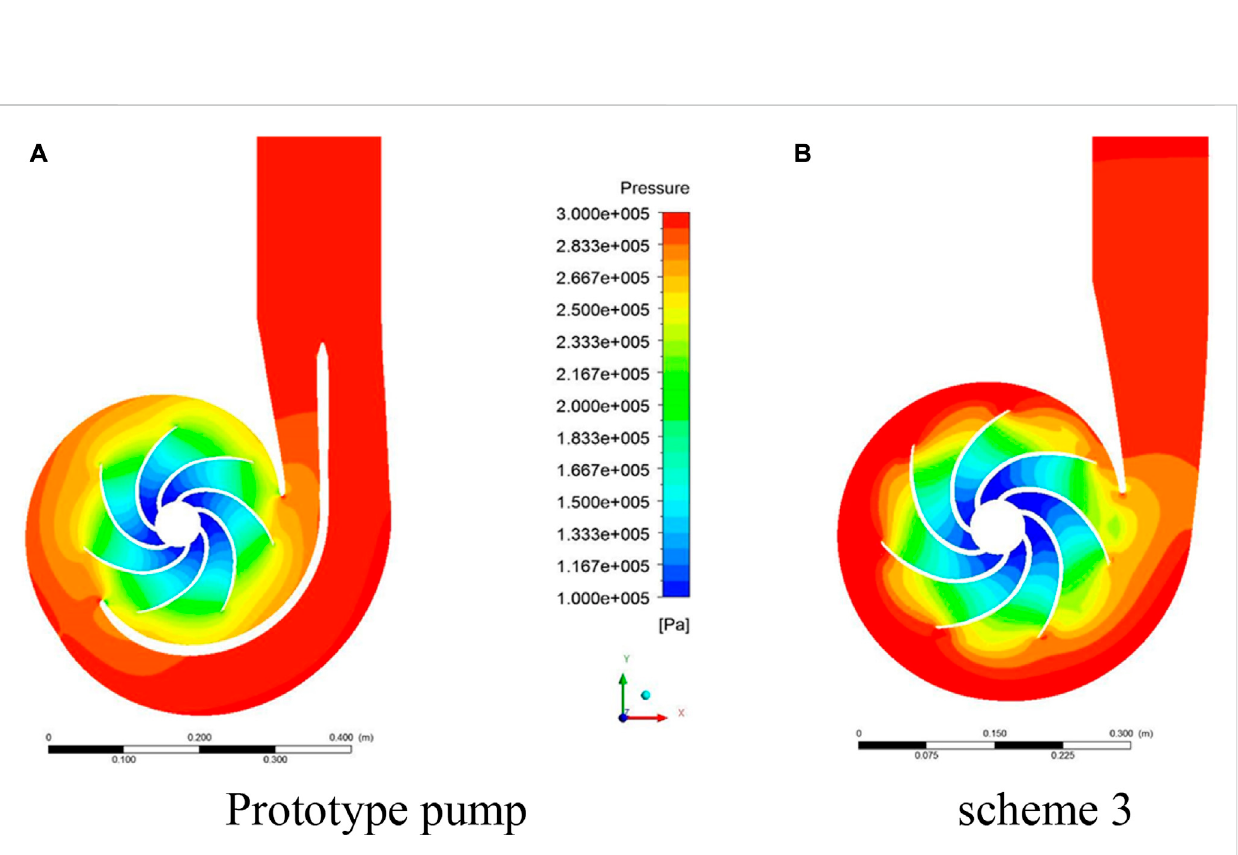
FIGURE 15 The static pressure distribution in the Z -axis direction under design conditions. (A) Prototype pump; (B) Scheme